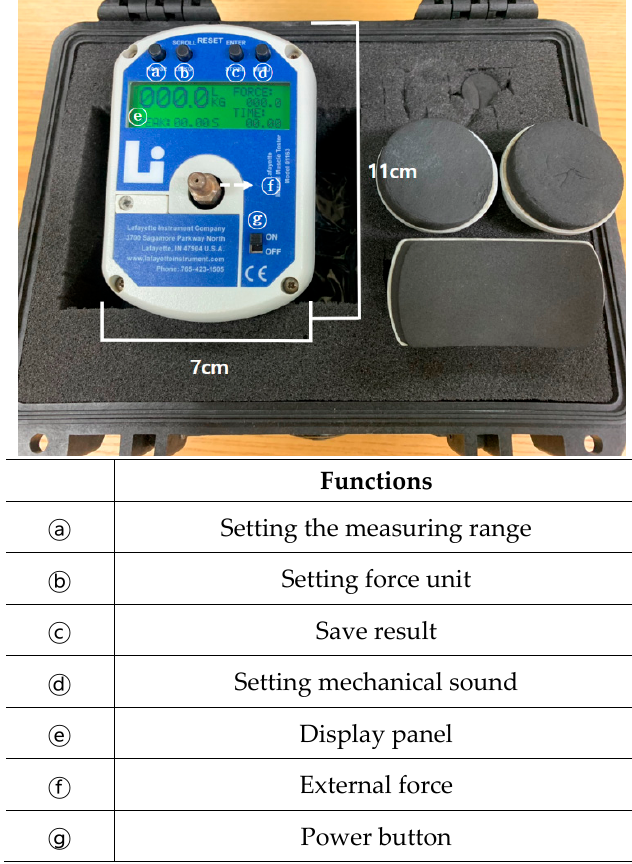
Figure 1. Manual muscle tester.